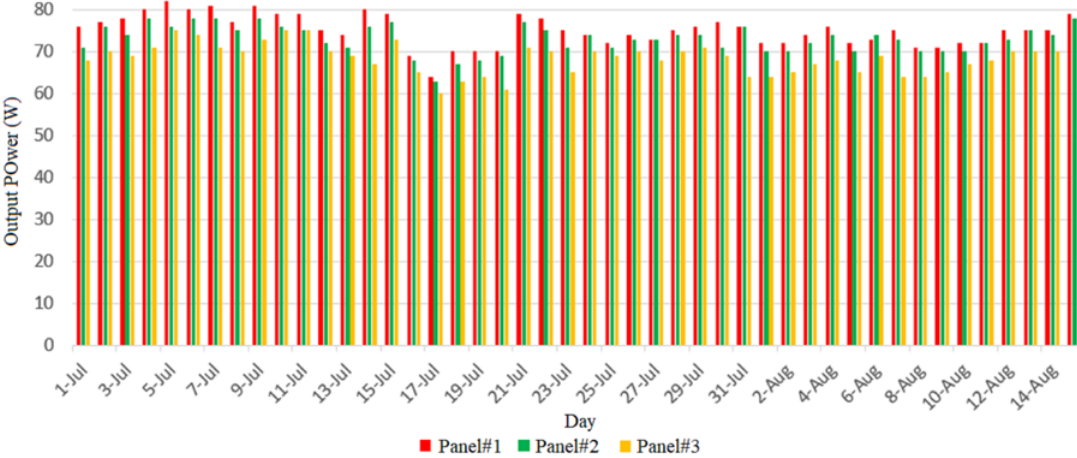
Figure 11. The average power generated by the three panels (during 2019); panel 1: SiO 2 nano-coated panel; panel 2: manual cleaning panel without a coating of any material; panel 3: dusty panel.